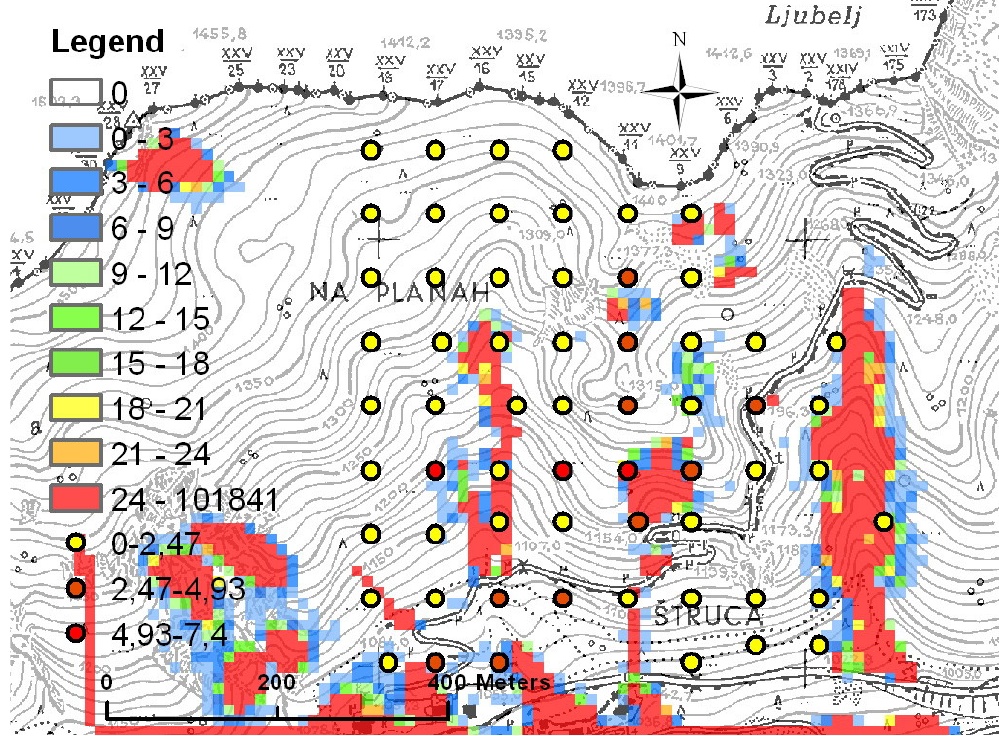
Figure 5. Number of deposited rocks for the non-forested slope scenario (coloured) and silent witnesses ( i.e. , number of retained stones per tree, labeled by coloured circles).